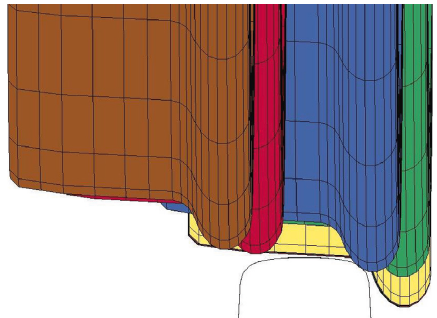
Figure 6: Derailment situation of wheels by wheel climbing on simulation.